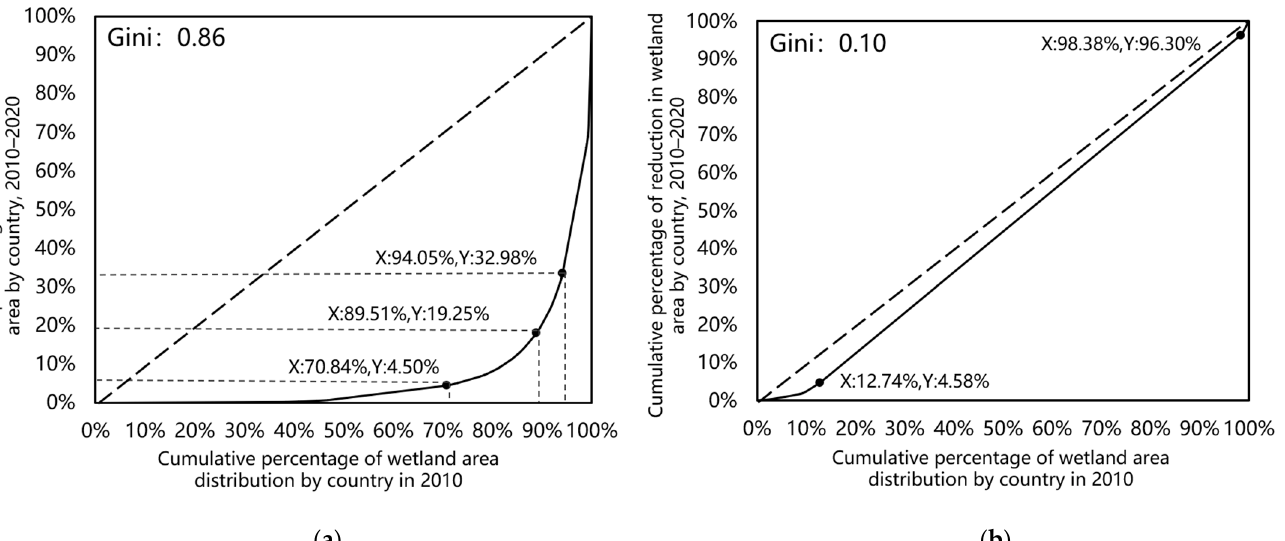
Figure 13. Lorenz curves representing the equality of wetland area changes from 2010 to 2020. ( a ). Lorenz curve for the area increase. ( b ). Lorenz curve for the area decrease.